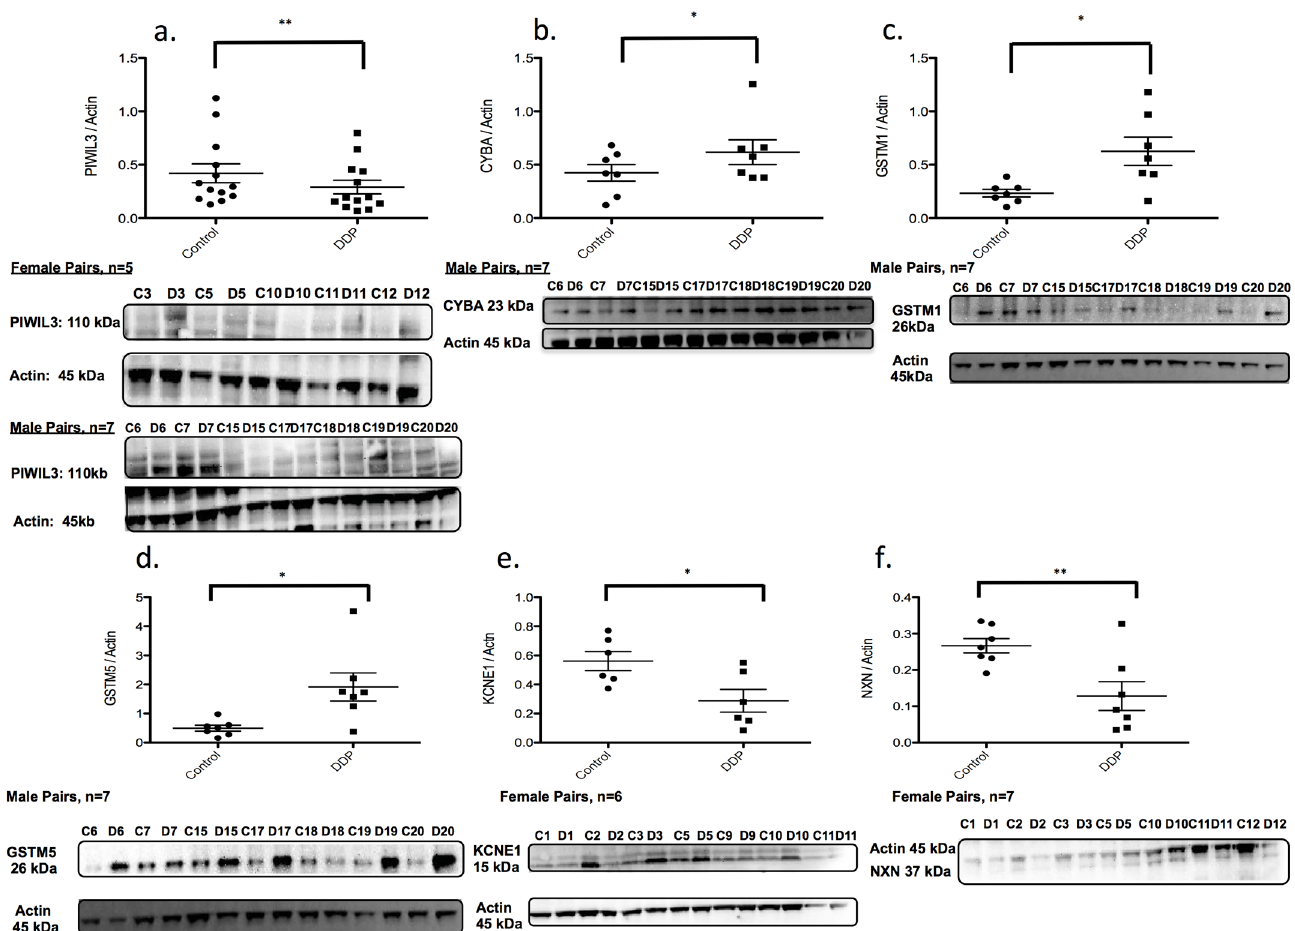
Fig 5. Protein abundance for genes with changes in DNA methylation and mRNA expression. a. PIWIL3 b. CYBA c. GSTM1 d. GSTM5 e. KCNE1 f. NXN; a–f: Protein abundance normalized to Actin or cofillin. a: All pairs (N = 14; 7 male pairs and 7 female pairs). b-d: Male offspring pairs (n = 7). e-f: Female offspring pairs (n = 7). (cid:3) p < 0.05; (cid:3)(cid:3) p < 0.05.